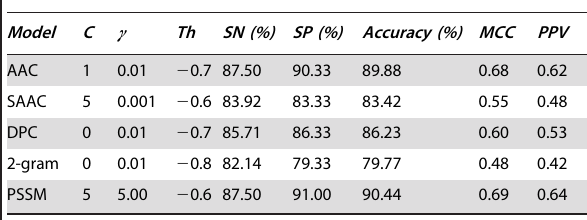
Table 1. Performance of different SVM classifiers in LOO CV.